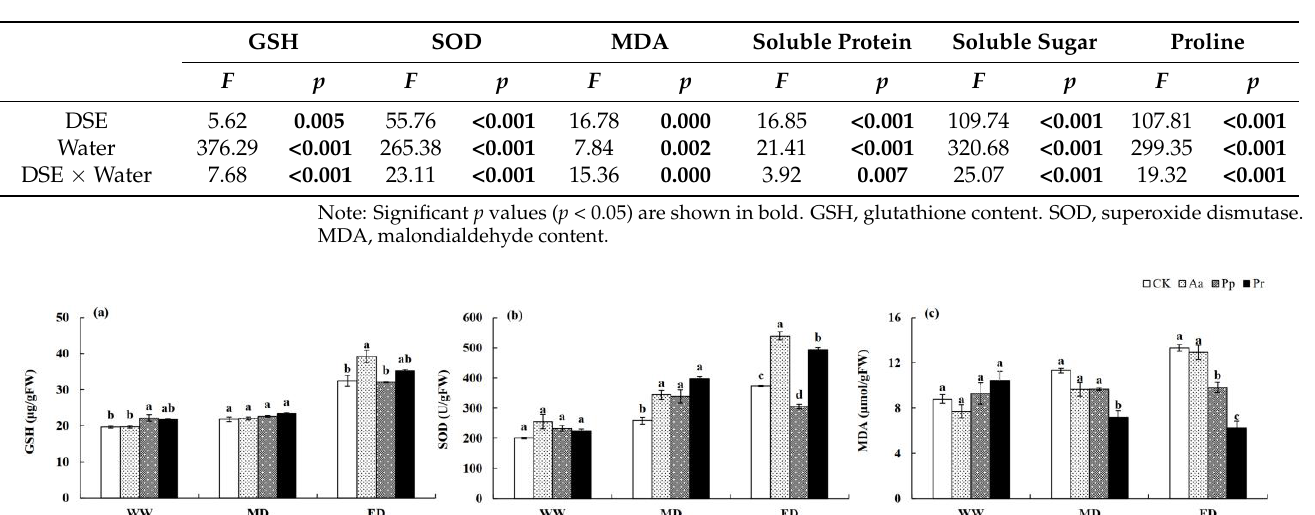
Table 2. The influences of DSE (DSE) and water (Water) treatments on the physiological indexes of wheat leaves based on two-way analysis of variance (ANOVA).